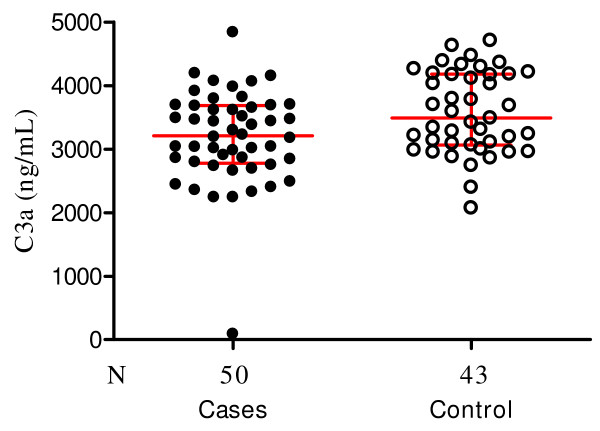
Scatter plot showing the median and interquartile C3a levels in children with severe malaria anaemia (cases) and those with uncomplicated malaria (controls). The median values were significantly higher in the controls (3,500 ng/ml, 3,100–4,200) compared to the cases (3,200 ng/mL, 2,800–3,700) P = 0.02). Wilcoxon matched-pairs signed-ranks test was performed with the 43 paired samples.